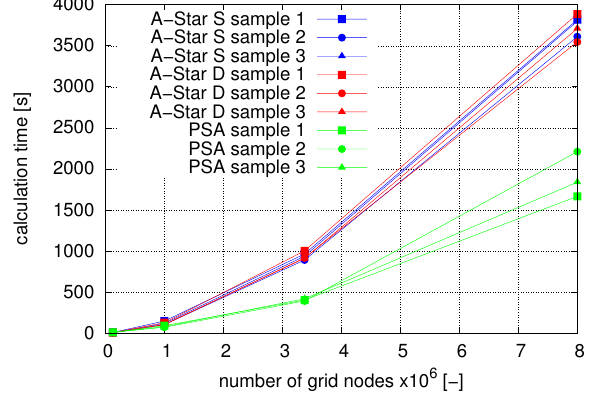
Figure 17. Real calculation time in the function of the number of grid nodes.